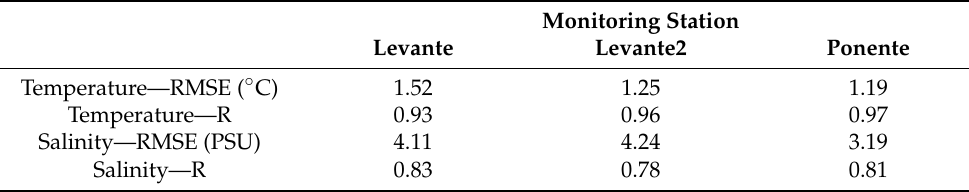
Figure 6. Comparison of time series of hourly salinity measured at the different monitoring stations and simulated by the numerical model. From the top to the bottom, stations of Levante, Levante2, and Ponente. Table 2. Validation of the numerical model for temperature and salinity: Root Mean Square Error (RMSE) and correlation coefficient (R) with filed data measured at the different monitoring stations for year 2020. Indexes are relative to the time windows in which the pumping system was turned